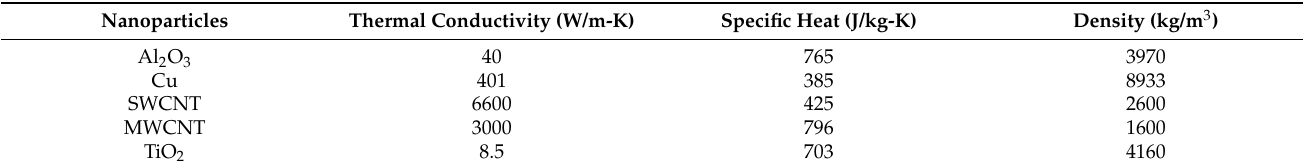
Table 1. Thermophysical and mechanical properties of nanoparticles [40–43]. Nanoparticles Thermal Conductivity (W/m-K)